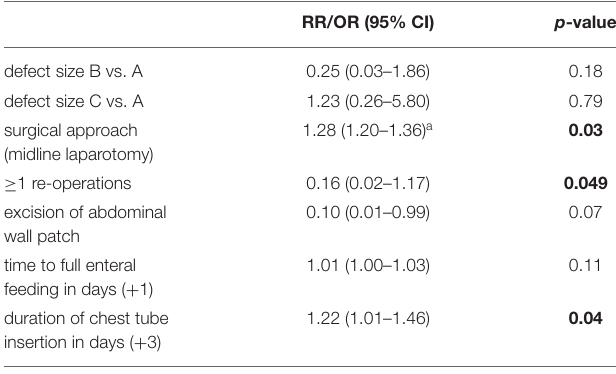
TABLE 12 | Likelihood of adhesive small bowel obstruction (ASBO) as a function of the duration of chest tube insertion and the number of re-operations. Likelihood in %, no